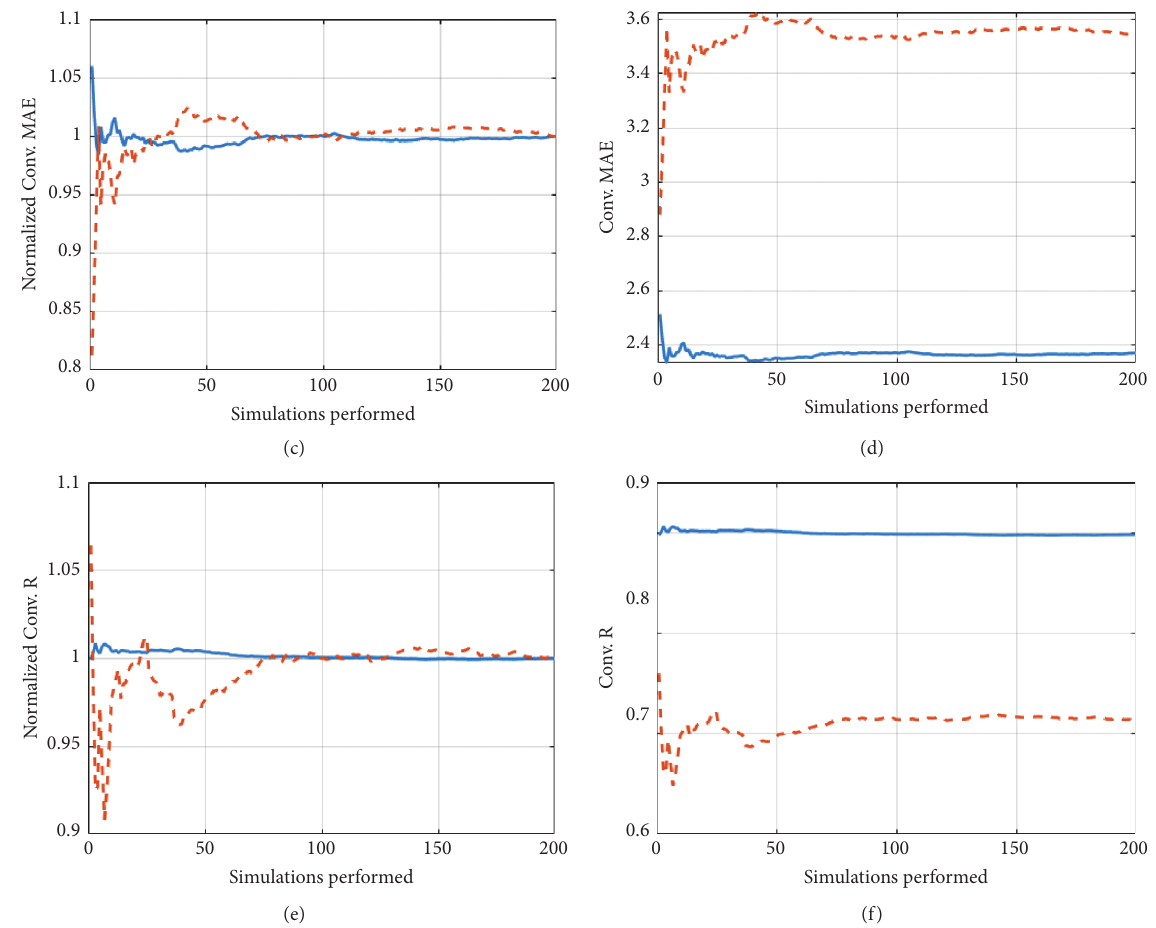
Figure 9: Analysis of simulation convergence over 200 runs with respect to (a) normalized convergence values of RMSE, (b) convergence values of RMSE, (c) normalized convergence values of MAE, (d) converged values of MAE, (e) normalized convergence values of R, and (f) converged values of